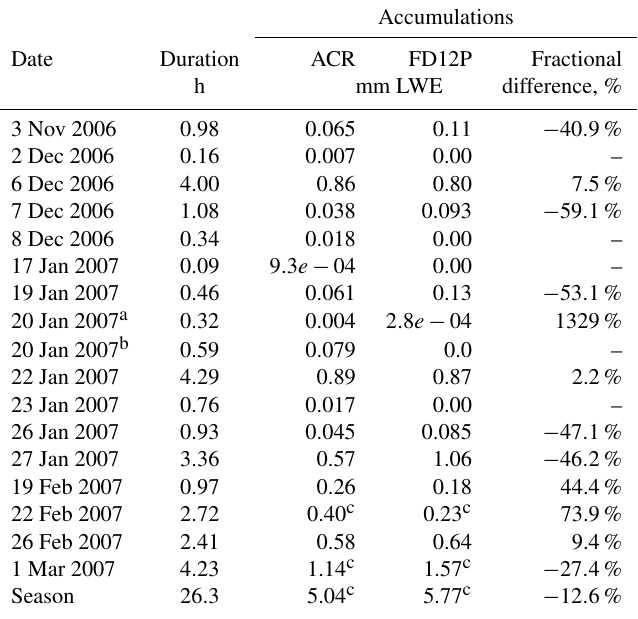
Table 1. Accumulations by event for the ACR retrievals. Duration shows the elapsed time of ACR observations for which retrievals were performed. Fractional differences are relative to FD12P accumulations.